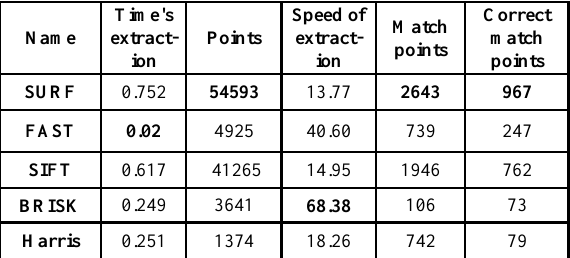
Table 3. Comparison of point extraction algorithms, data set 2